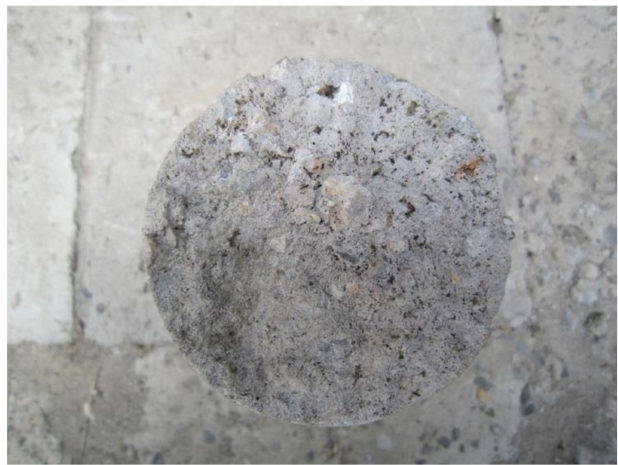
Figure 20. Broken weak interlayer between concrete and